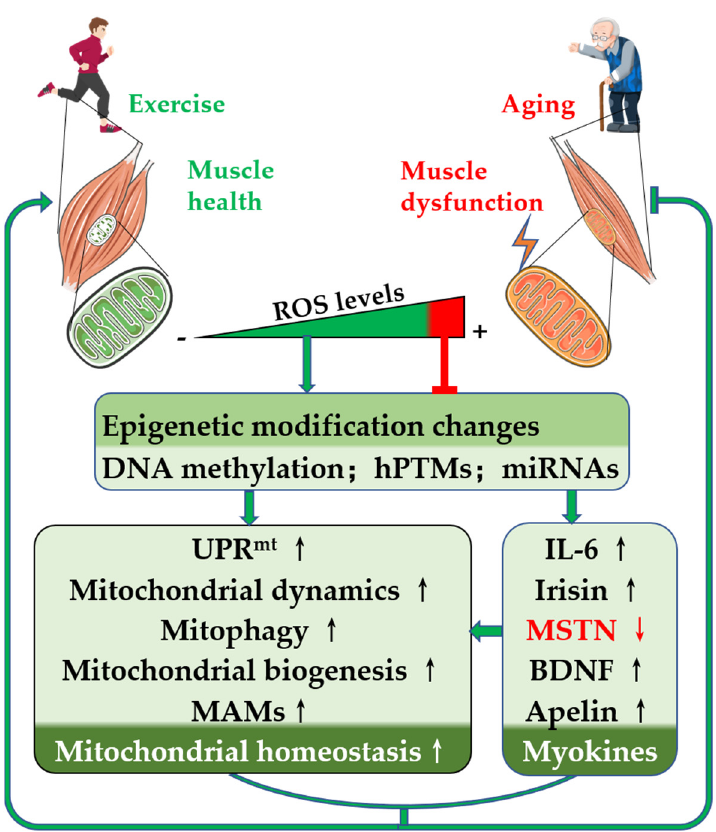
Figure 3. Exercise-induced ROS ameliorate aging skeletal muscle dysfunction via epigenetic regulation of mitochondrial homeostasis. With increasing age and decreasing exercise, ROS accumulation in skeletal muscle occurs. High ROS levels promote mitochondrial and skeletal muscle dysfunction. Exercise-induced physiological levels of ROS promote mitochondrial quality control and improve myokine expression by altering epigenetic modifications, which subsequently maintain mitochondrial homeostasis and promote skeletal muscle health. For abbreviations, see the list at the end of the paper.